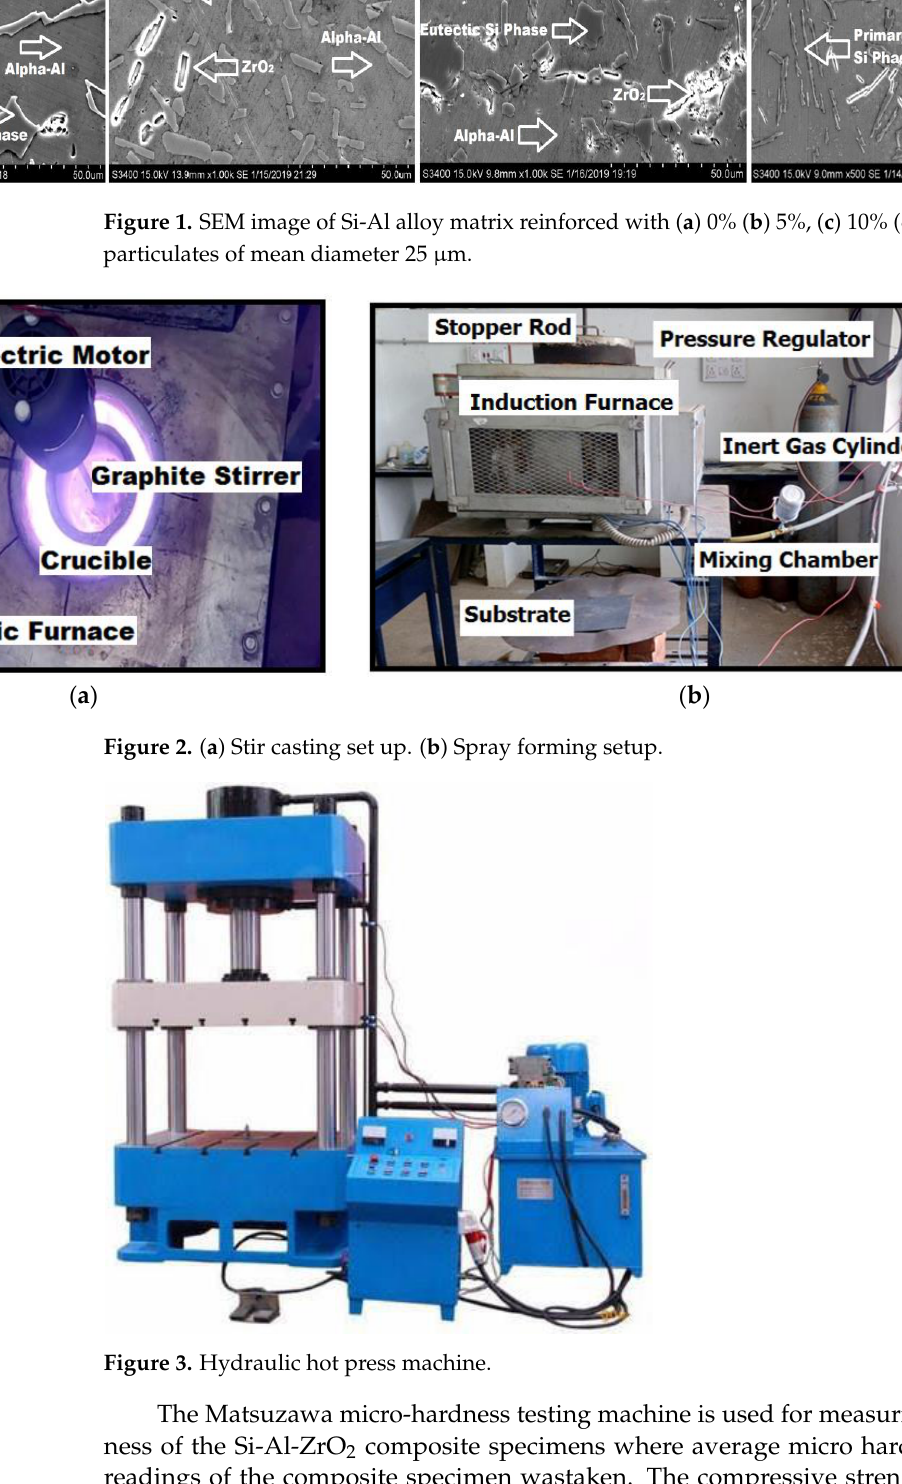
Figure 4. Compression test sample.